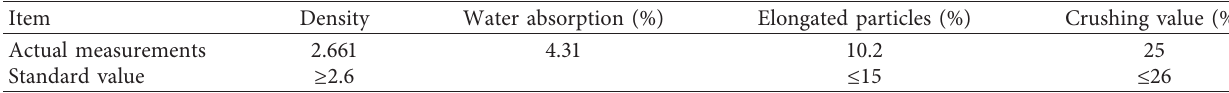
Table 5: Sandstone technical index test results.